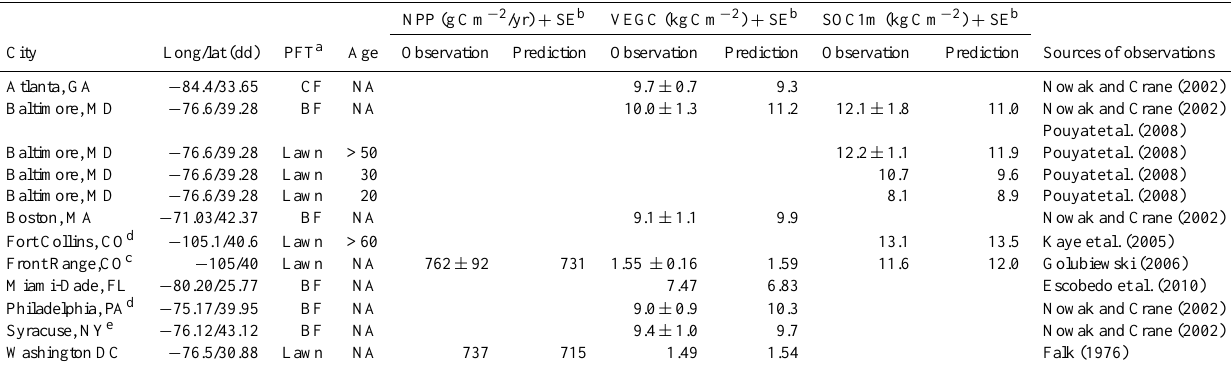
Table 4. Comparison of model predictions against observed carbon pools and fluxes of urban ecosystems.